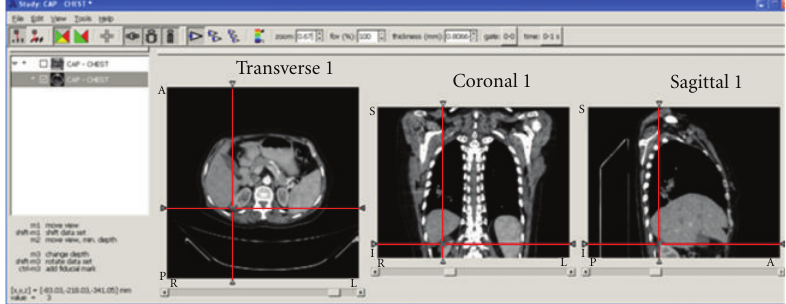
Figure 20: AMIDE snapshot locating the kidney cancer.